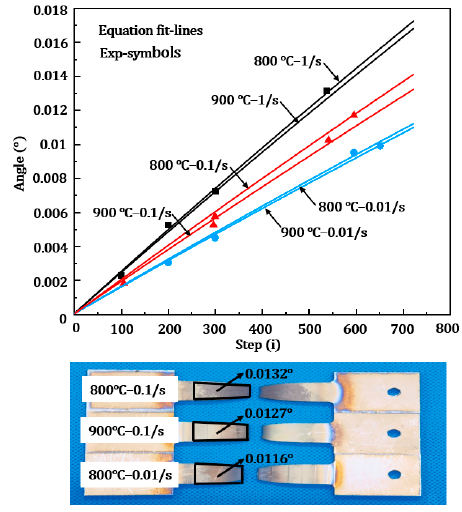
Figure 7. Prediction of angle equation.